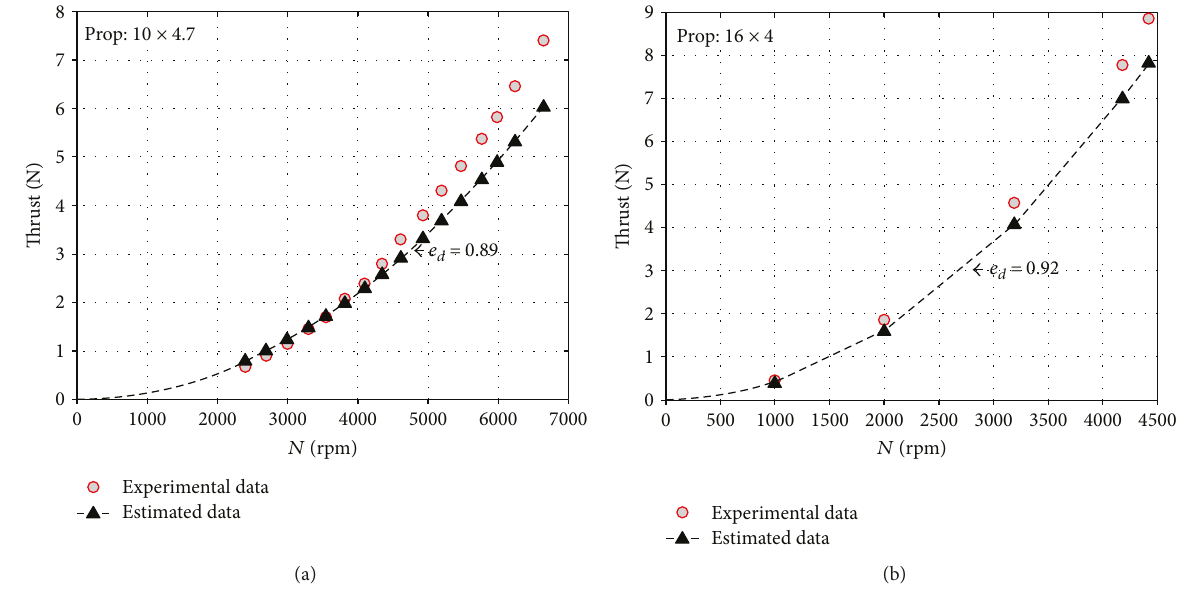
Figure 7: Validation of the Thrust-RPM mathematical